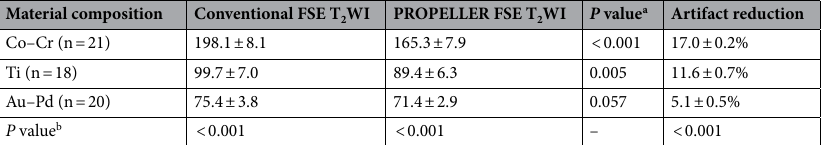
Table 3. Comparison of artifact areas of different metal crowns in conventional FSE T 2 WI and PROPELLER FSE T 2 WI sequences(mm 2 ). FSE T 2 WI, fast spin echo T 2 weighted imaging; PROPELLER FSE T 2 WI, periodically rotated overlapping parallel lines with enhanced reconstruction fast spin echo T 2